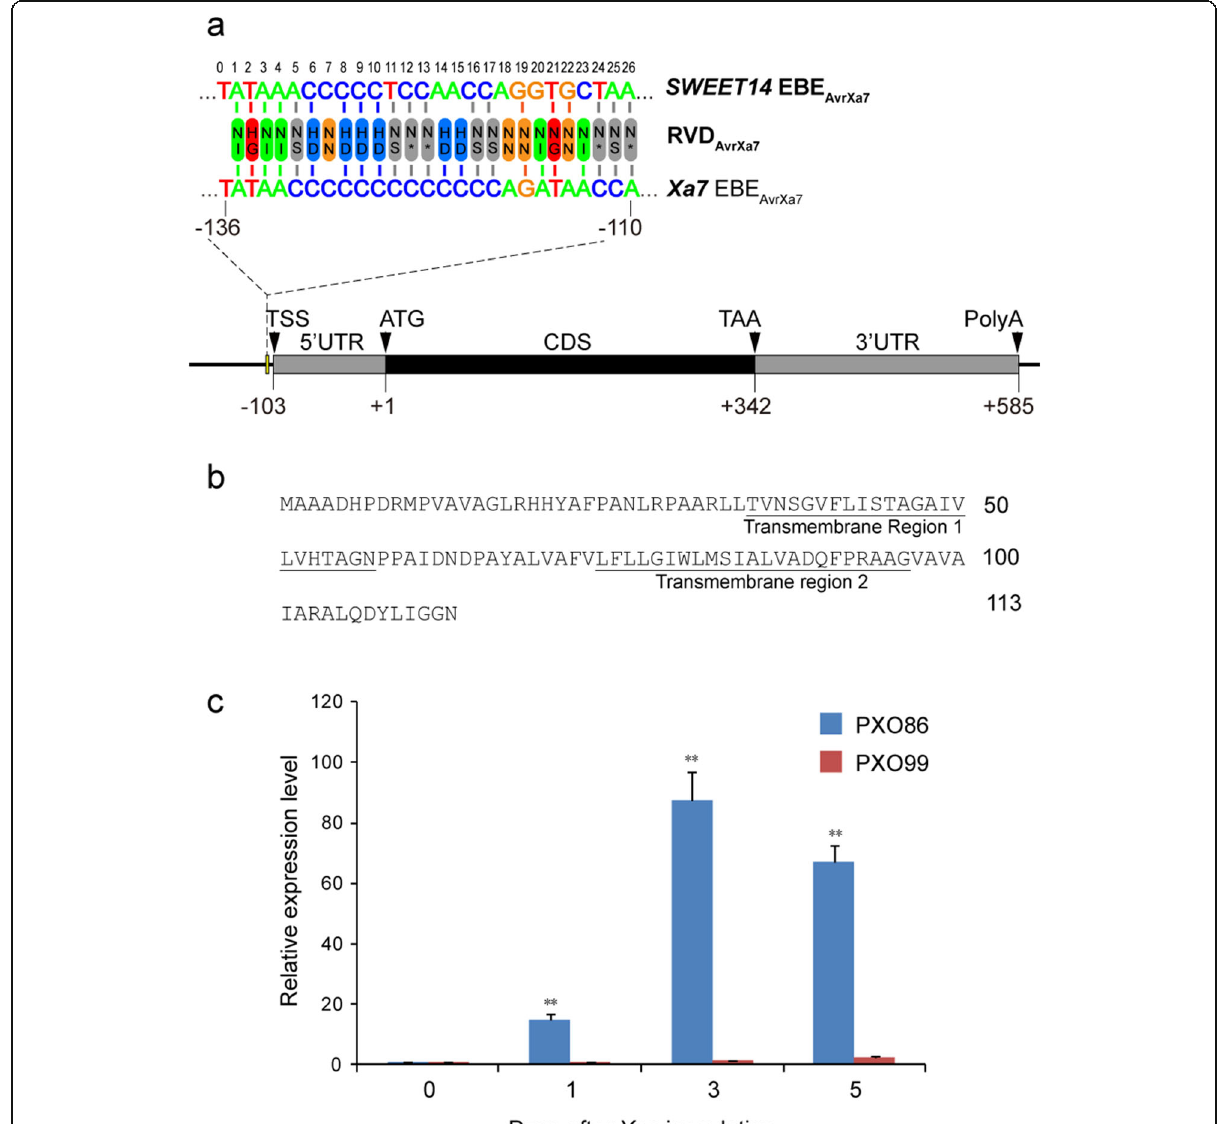
Fig. 3 The structure and expression characterization of Xa7 . ( a ) Gene structure of Xa7 . The schematic map shows the EBE AvrXa7 (110 – 136 bp upstream of the ATG start code), the coding region (black rectangle), and the 5 ′ and 3 ′ UTR regions (gray rectangles). The numbers indicate the distance from ATG code initiation site for each element or substructure. ( b ) The deduced amino acid sequence of XA7. The transmembrane helices are underlined. ( c ) Expression pattern of Xa7 gene after inoculation with Xanthomonas oryzae pv. oryzae ( Xoo ) strain PXO86 and PXO99, respectively. The average expression level of Xa7 in IRBB7 at 0 d was set as “ 1 ” . The expression levels of other time point were used to compare with that of 0d. The data represents the mean ± standard deviation ( n = 3 replicates). Student ’ s t -test analysis indicates a significant difference (compared with control, ** P <